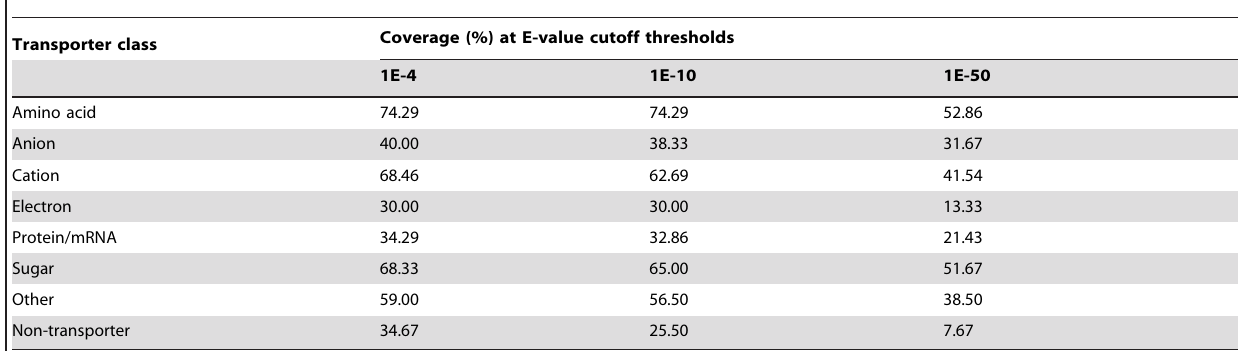
Table 8. The performance (coverage metric) of the PSI-BLAST search on the main dataset using a five-fold cross-validation.